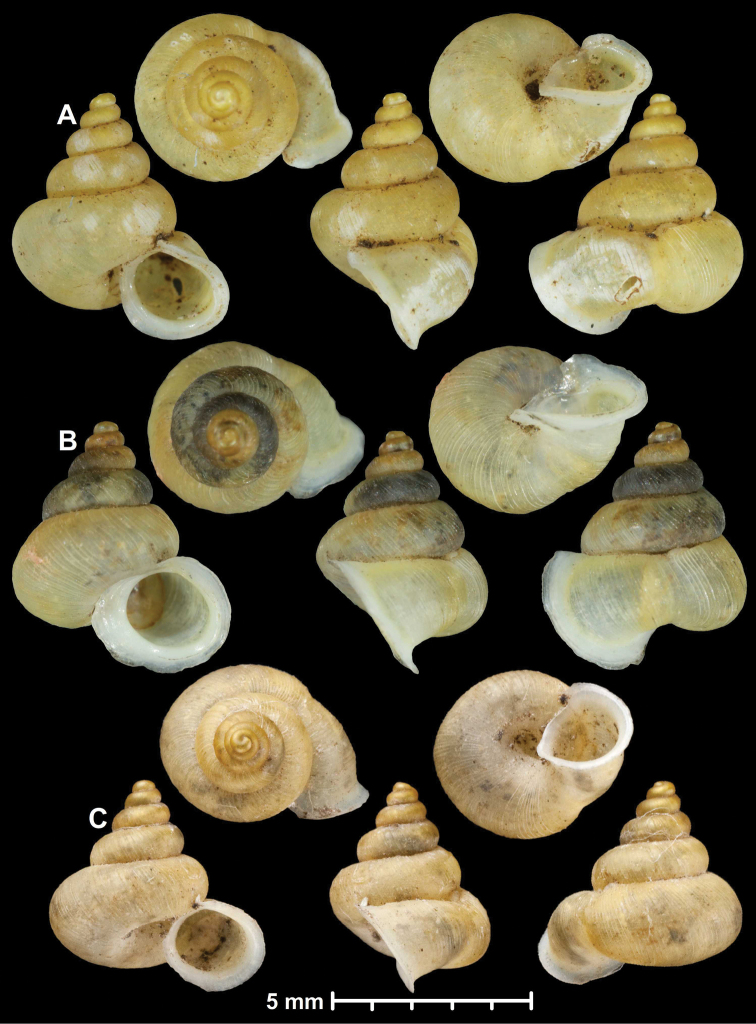
Shells of Stomacosmethis Bollinger, 1918 species AS.
praetextus (van Benthem Jutting, 1959), paratype (SMF 186532) BS.
rimatus (O. Boettger, 1893), lectotype (SMF 109315) CStomacosmethis
sadongensis (E. A. Smith, 1895), syntype (NHMUK 1893.6.7.73–76). Photographs: Barna Páll-Gergely, courtesy Ronald Janssen (A, B), Harold Taylor (C).